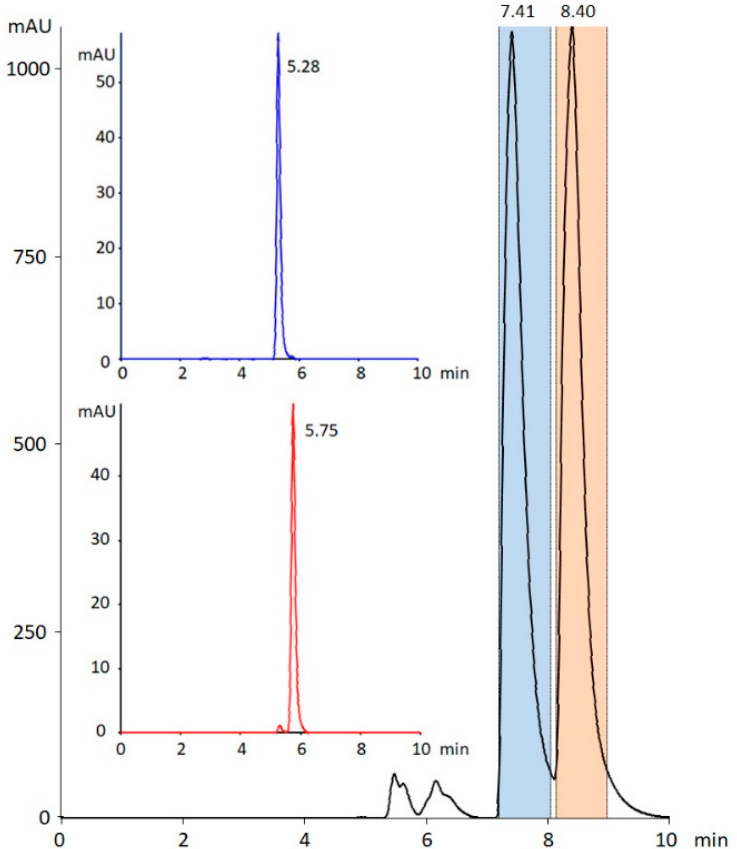
Figure 3. Preparative enantioseparation of 4-IBMCat with the marked boundaries for the collection of the first and the second eluting enantiomers. The insets show the analytical control of the optical purity of the collected enantiomers: 4-IBMCat 1 ( blue , top ) and 4-IBMCat 2 ( red , bottom ).